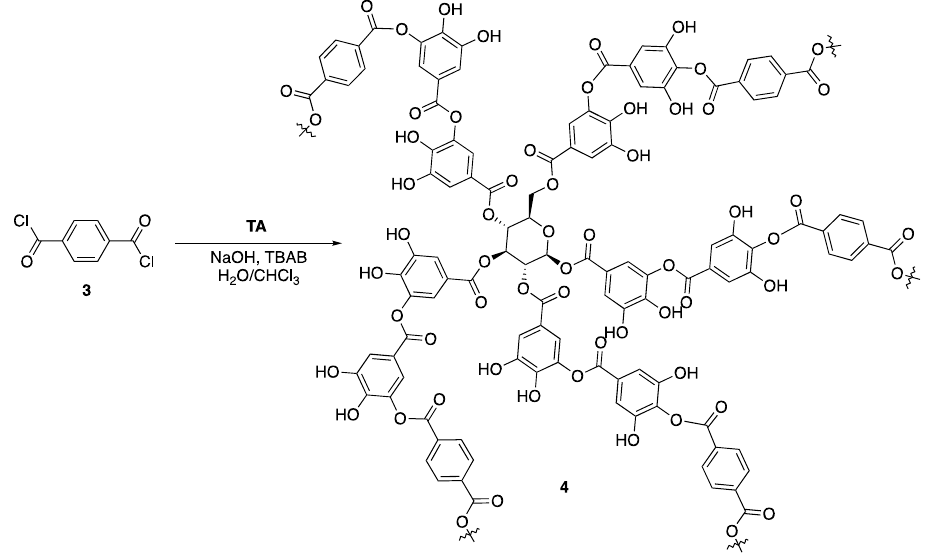
Figure 4. Preparation of tannic acid-terephthalate (TAT) 4. Table 3. Vertical flame test